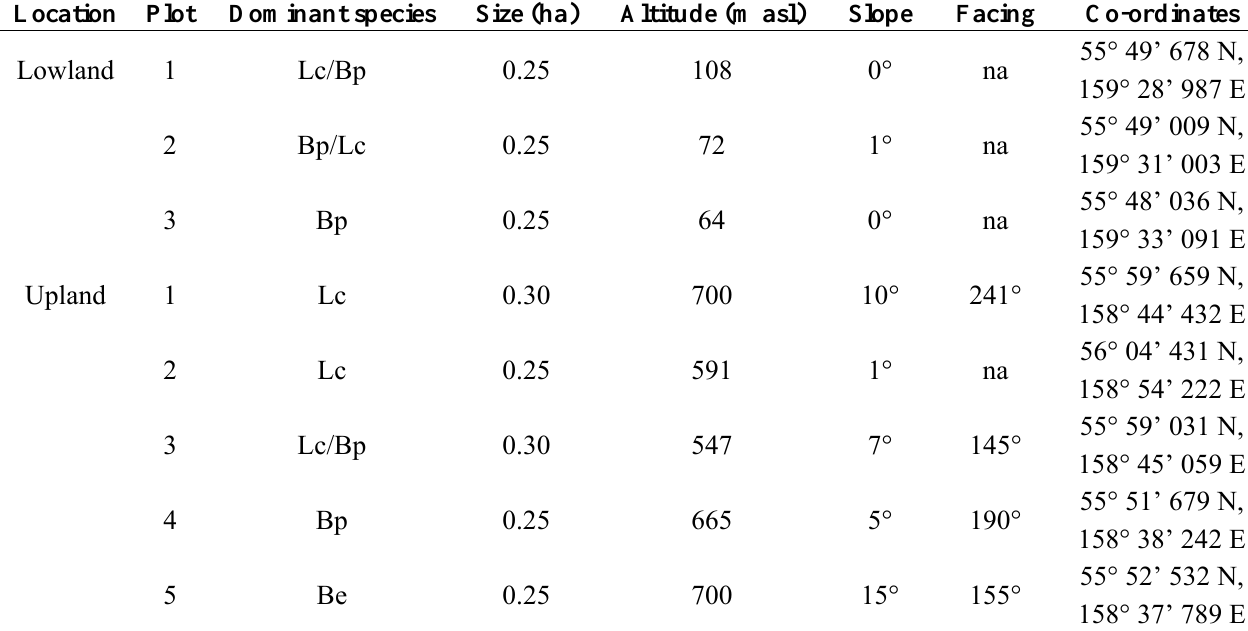
Table 1. Characteristics of old-growth forest plots in Central Kamchataka. Dominant tree species are determined on the basis of importance values exceeding 20 (see Table